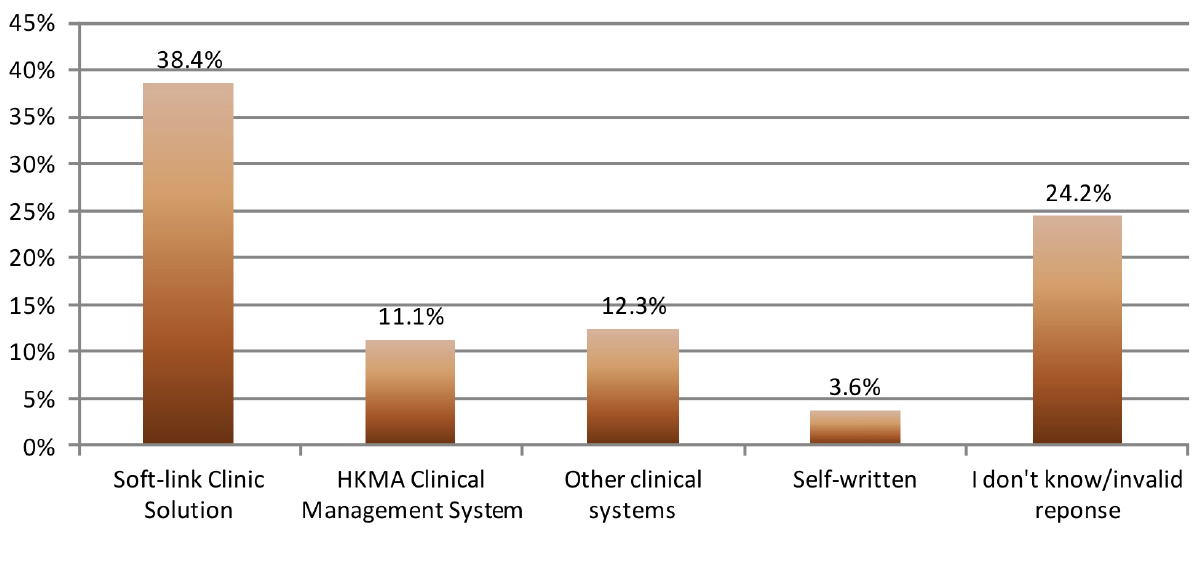
Figure 5. The proportion of participants adopting various vendors. HKMA: Hong Kong Medical Association.